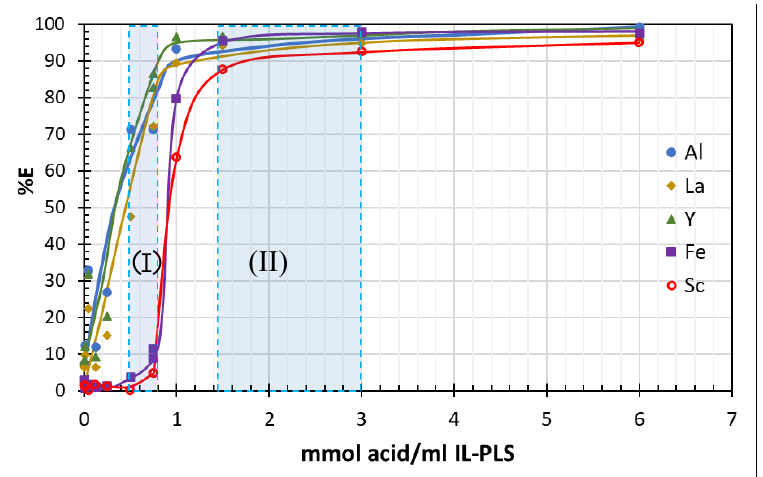
Figure 3. Extraction of metals as a function of the stoichiometric addition of HCl acid.Area (I) selective extraction of metals, area (II) complete extraction of metals.